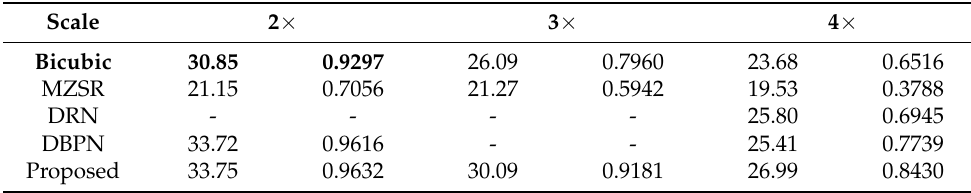
Figure 8. SR results of the third plate image (4 × ). ( a ) HR (144 × 40), ( b ) Bicubic, ( c ) DRN, ( d ) MZSR, ( e ) USRNet, ( f ) DBPN, ( g ) Proposed. Two characters were masked due to privacy policies. Table 3. Average PSNR/SSIM of license plates for